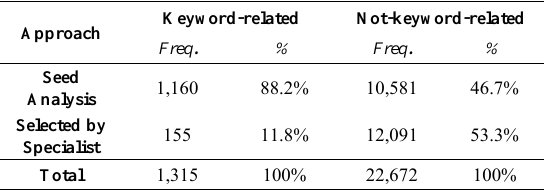
Table 3. Result of Chi-square test to data gathered by two different data gathering approaches